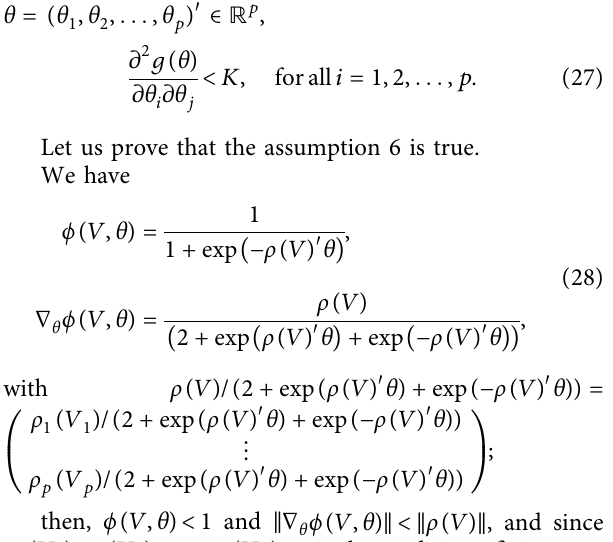
Table 1: Fisher scoring algorithm outputs.